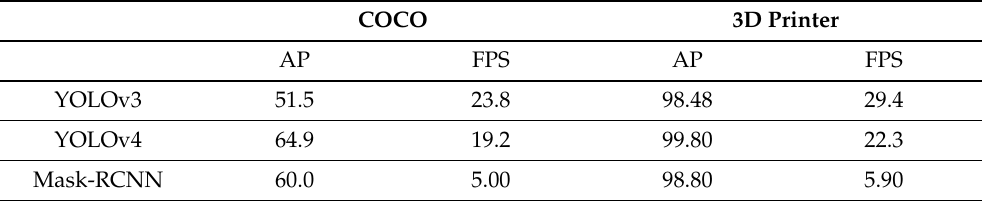
Table 1. The performance and frequency of three candidate models, where AP stands for mean average precision when IOU defined in Equation (5) are 0.5, and FPS stands for frame per second, the processing